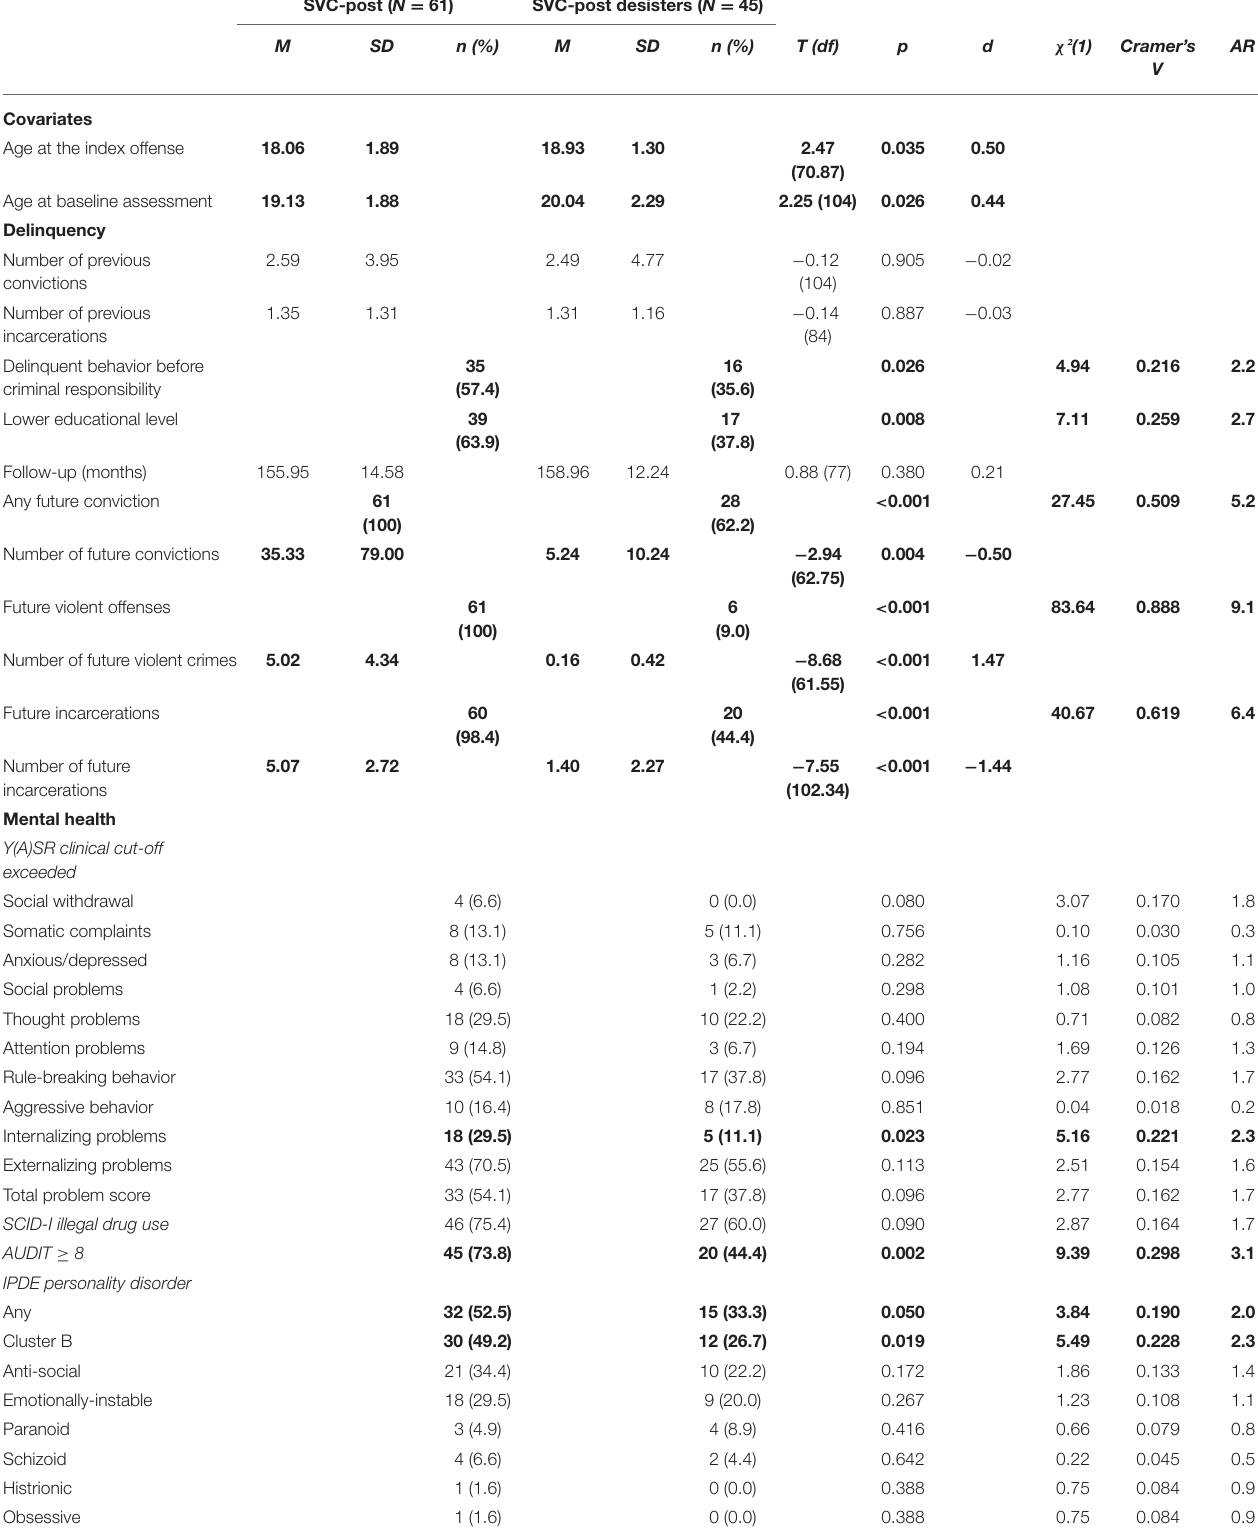
TABLE 2 | Differences between SVC-post offenders and SVC-post desisters. SVC-post ( N = 61) SVC-post desisters ( N = 45)